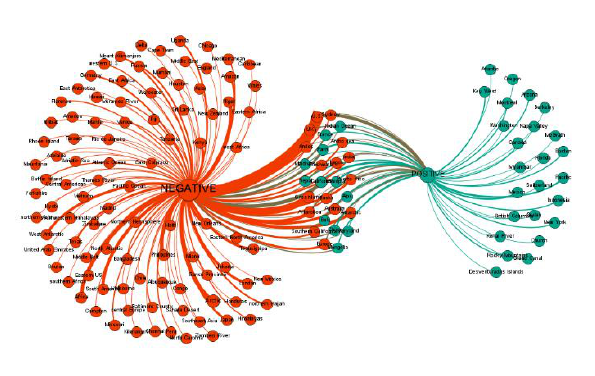
Figure 6 . Locations polarity network